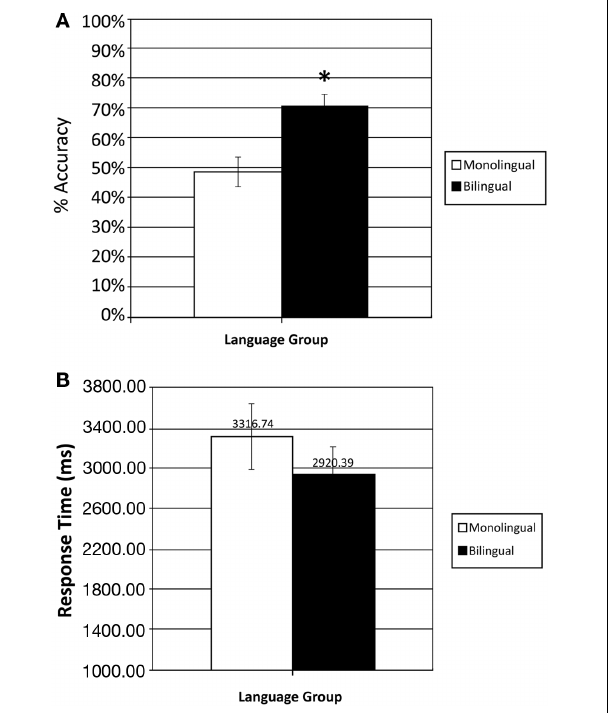
FIGURE 4 | Monolingual and bilingual children’s percentage of correct responses (A) and response time (B) in theAttention